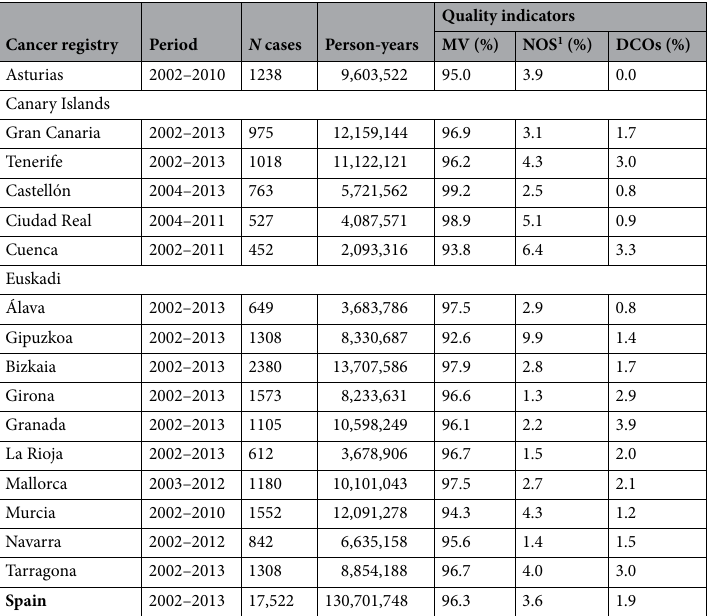
Table 1. Period of study, number of cases of myeloid neoplasms, and quality indicators of data provided by Spanish provinces. 1 NOS cases included the following ICD-O-3 codes: 9860, 9800. MV microscopically verified, NOS not-otherwise specified, DCO death certificate